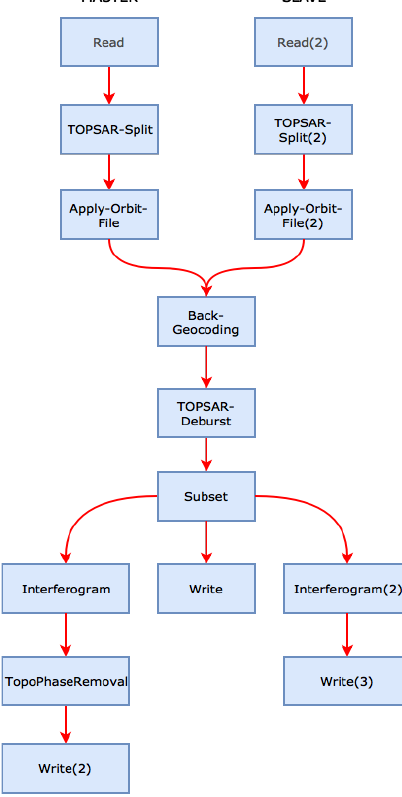
Figure 3. SNAP Graph of S1 TOPS Coregistration, debursting and